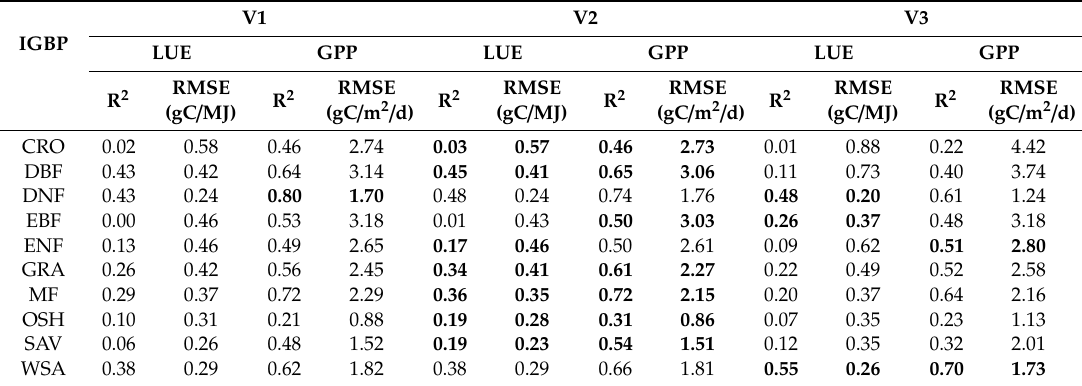
Table 3. Light use e ffi ciency (LUE) and gross primary productivity (GPP) validation for each type of